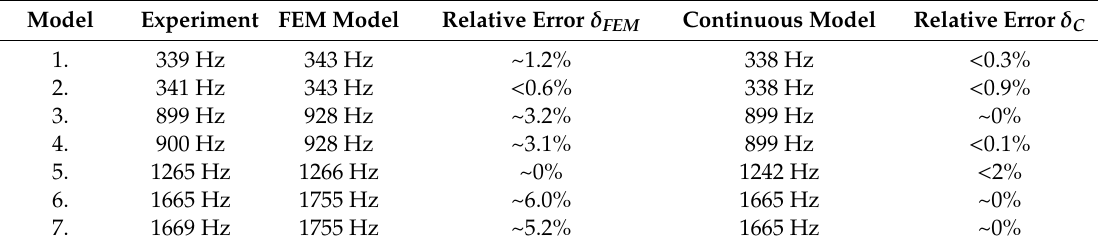
Table 5. Experimental verification of the natural frequencies of the steel–polymer concrete beam model following the identification of its parameters.